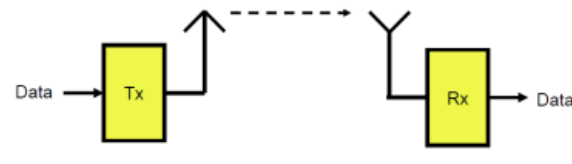
Figure 1. SISO principle demonstration - one signal at the input of the receiver, one at the output of the transmitters.